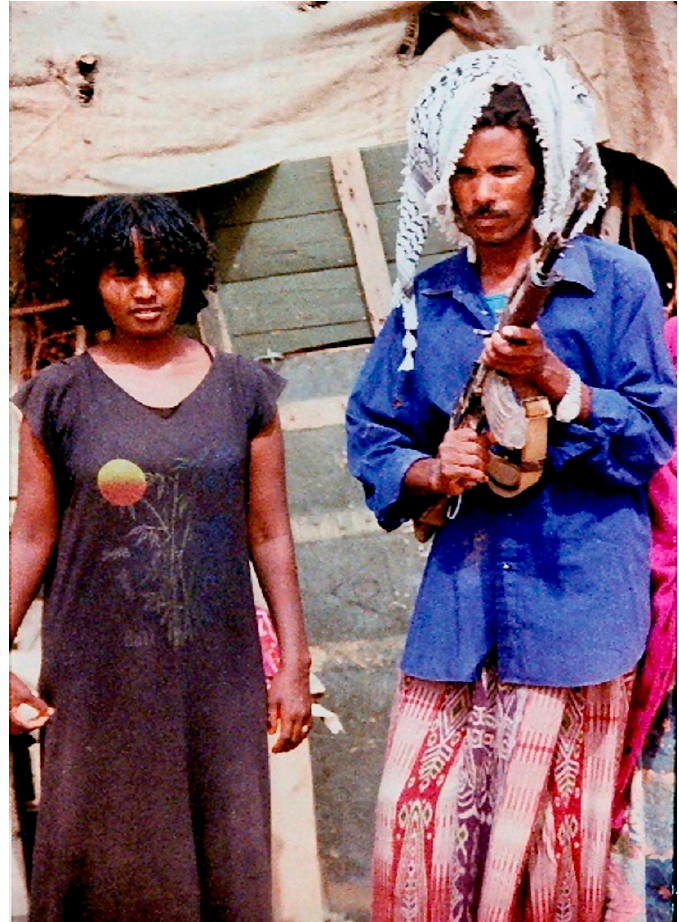
Figure 6. Eritrean People’s Liberation Front (EPLF) soldiers during the war for independence from Ethiopia; photo credit Gwynne Roberts (copyright Gwynne Roberts).